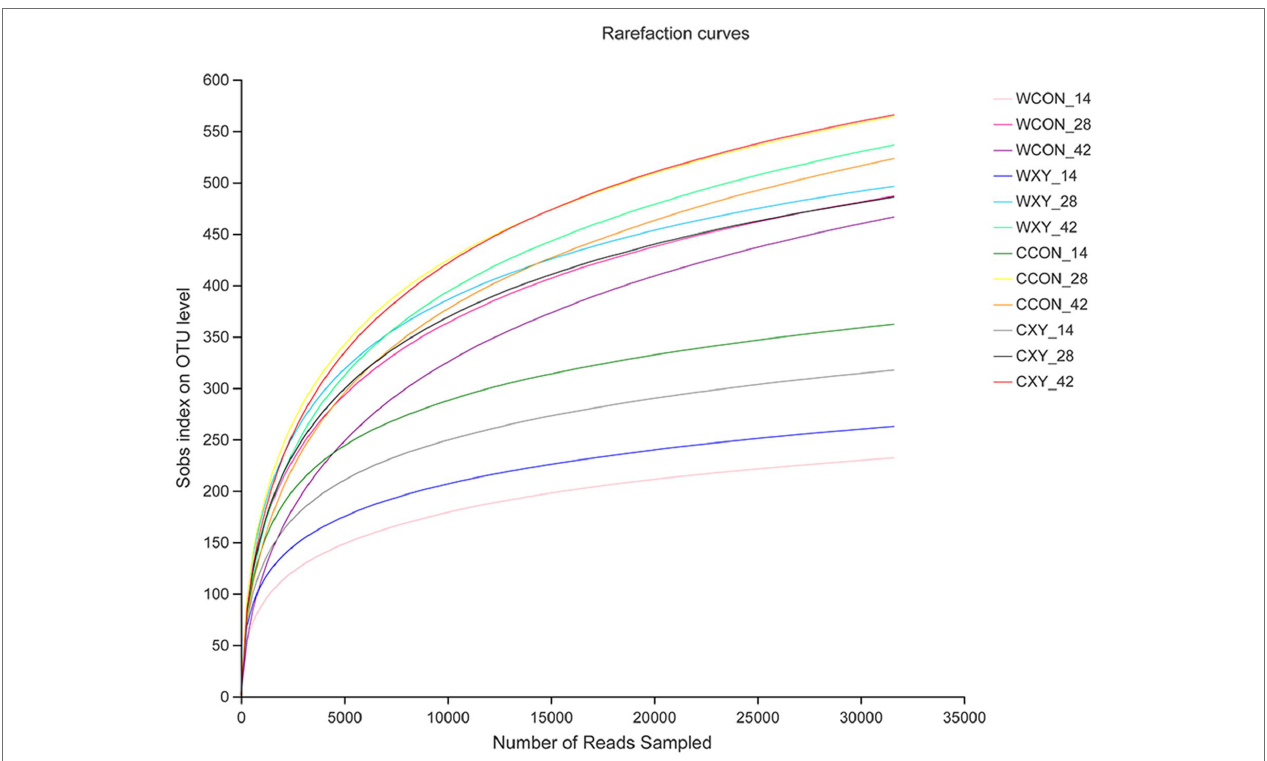
FIGURE 2 | Rarefaction curves showing sequence coverage across samples on the observed number of OTUs. For rarefaction plots, calculated based on the observed OTUs to determine the sequencing coverage across samples. OTUs, operational taxonomic units. Wheat-soybean basal diet (WCON); wheat-soybean